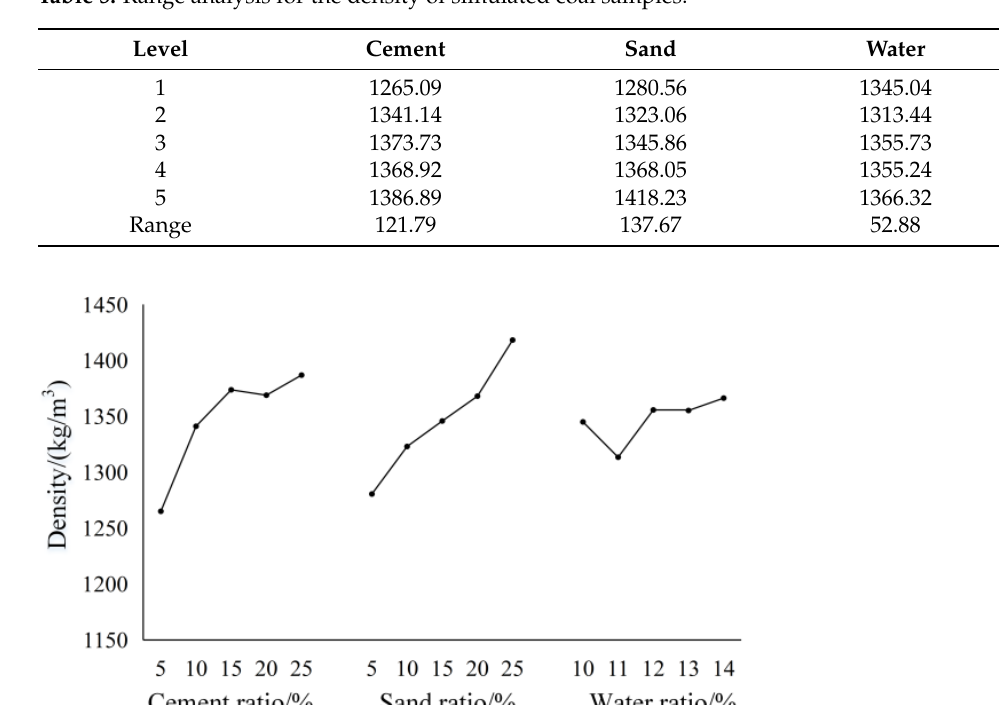
Table 5. Range analysis for the density of simulated coal samples.